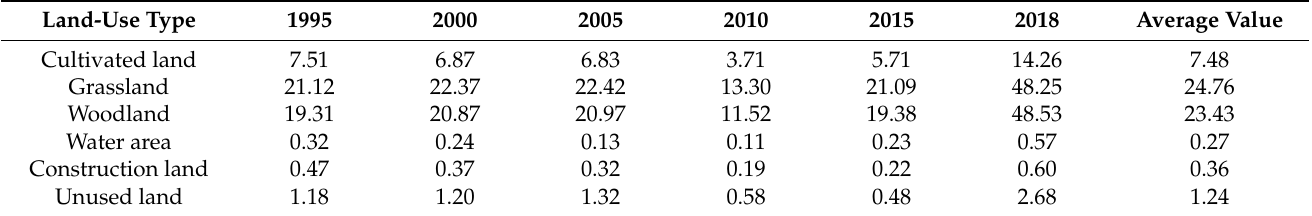
Table 4. Modulus of soil erosion in different years under different land-use types in the South and North Mountains of Lanzhou (unit: t/(km 2 ·